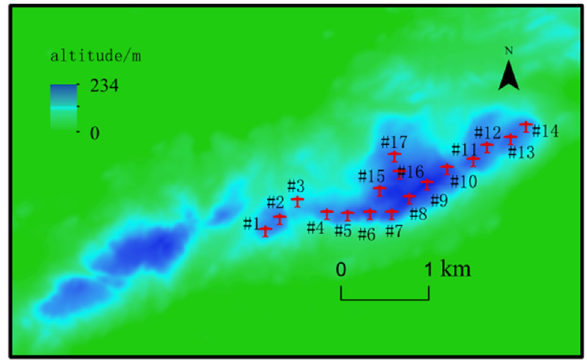
Figure 4. The topography of island wind farm.